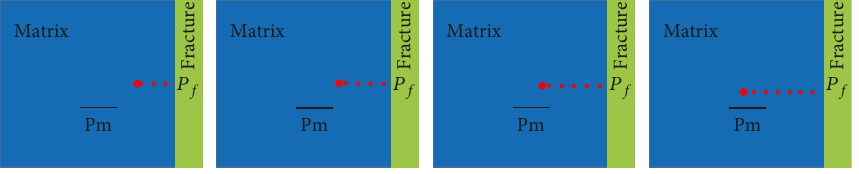
Figure 5: Schematic for the change of matrix average